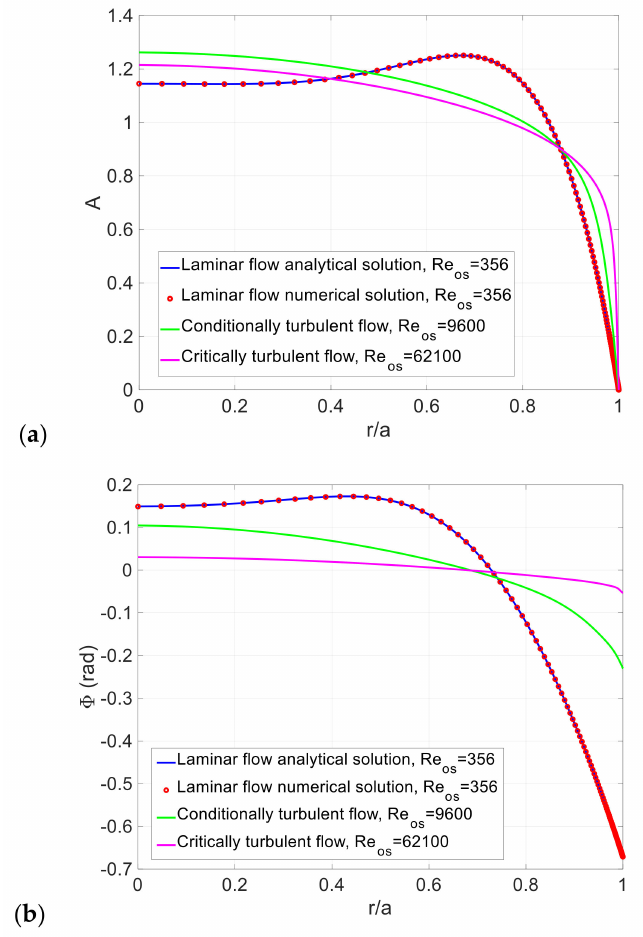
Figure 3. Amplitude and phase computations (see Equations (17) and (18)) compared to the analytical laminar solution [31,33] together with computation results corresponding to different turbulent flow regimes for increasing Re os at constant α = 10: ( a ) amplitude ratio; ( b )